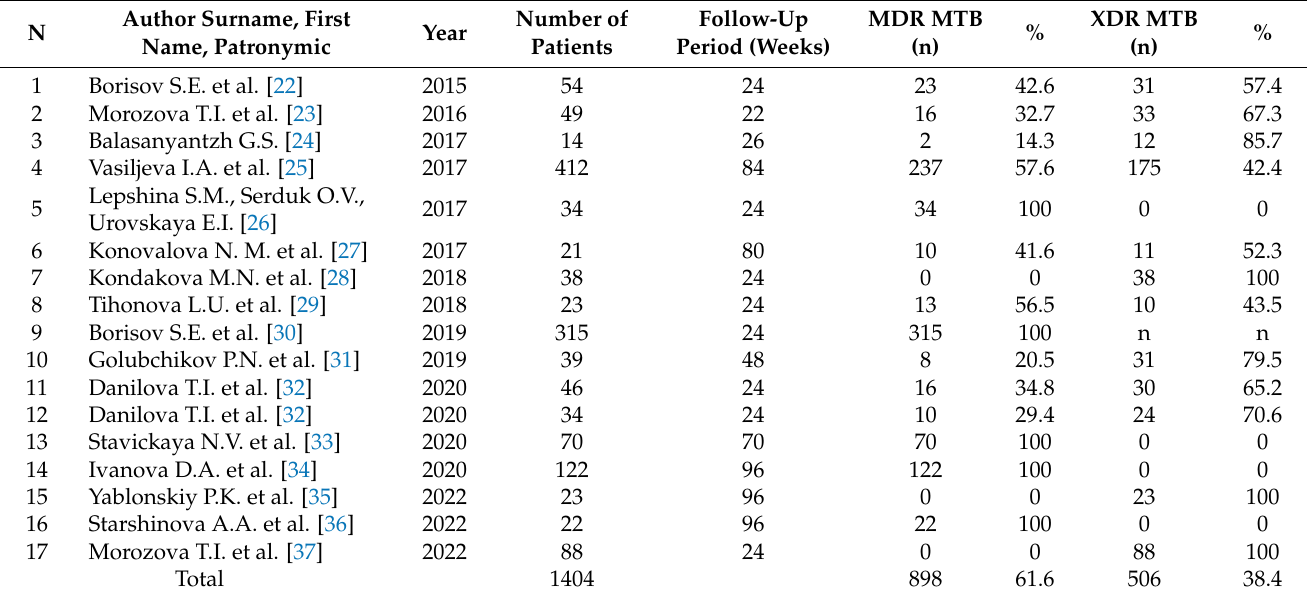
Table 1. Data on publications and enrolled